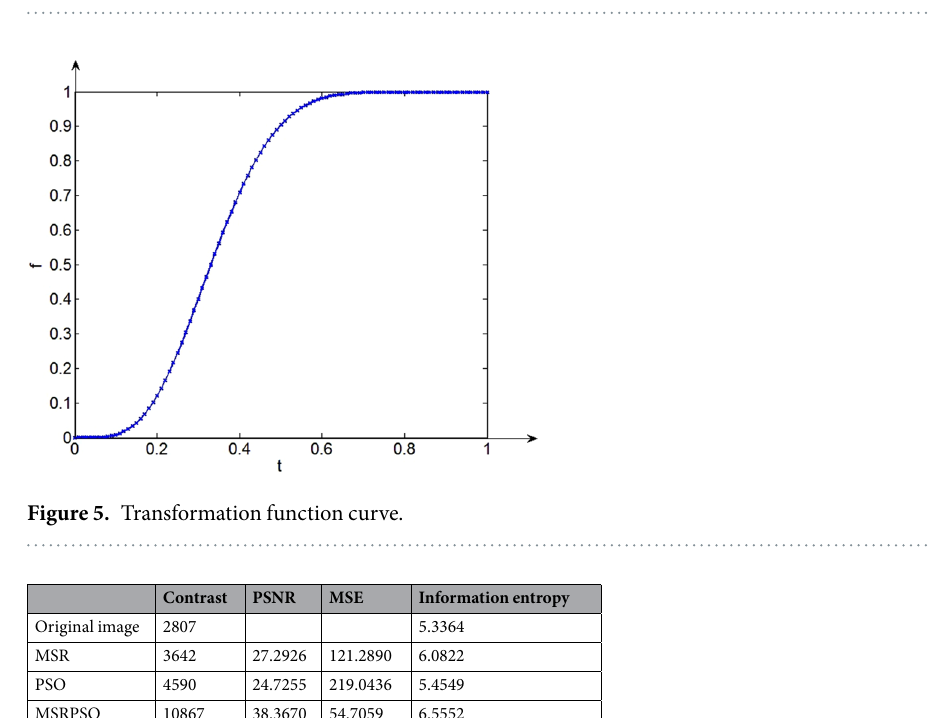
Figure 4. PSO algorithm optimization process.